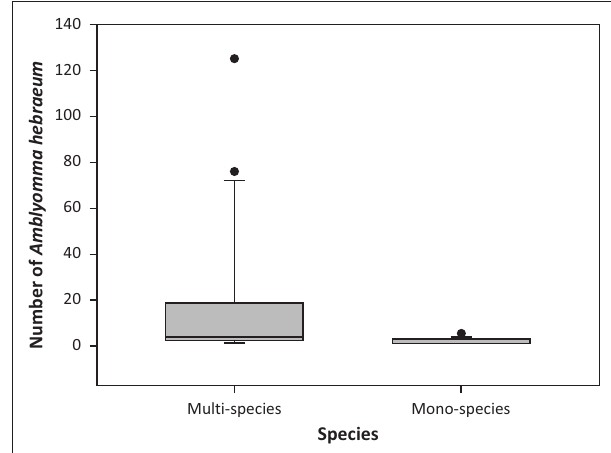
FIGURE 6: Boxplot depicting the number of Amblyomma hebraeum larvae collected from the vegetation in the grassland in the multi-species enclosure versus the sable antelope enclosures on the farm Hoopdal KQ96. The middle bar, the box and the whiskers refer to the median, the interquartile range and the interoctile (80 % ) range, whilst the dots are extremes or outliers.